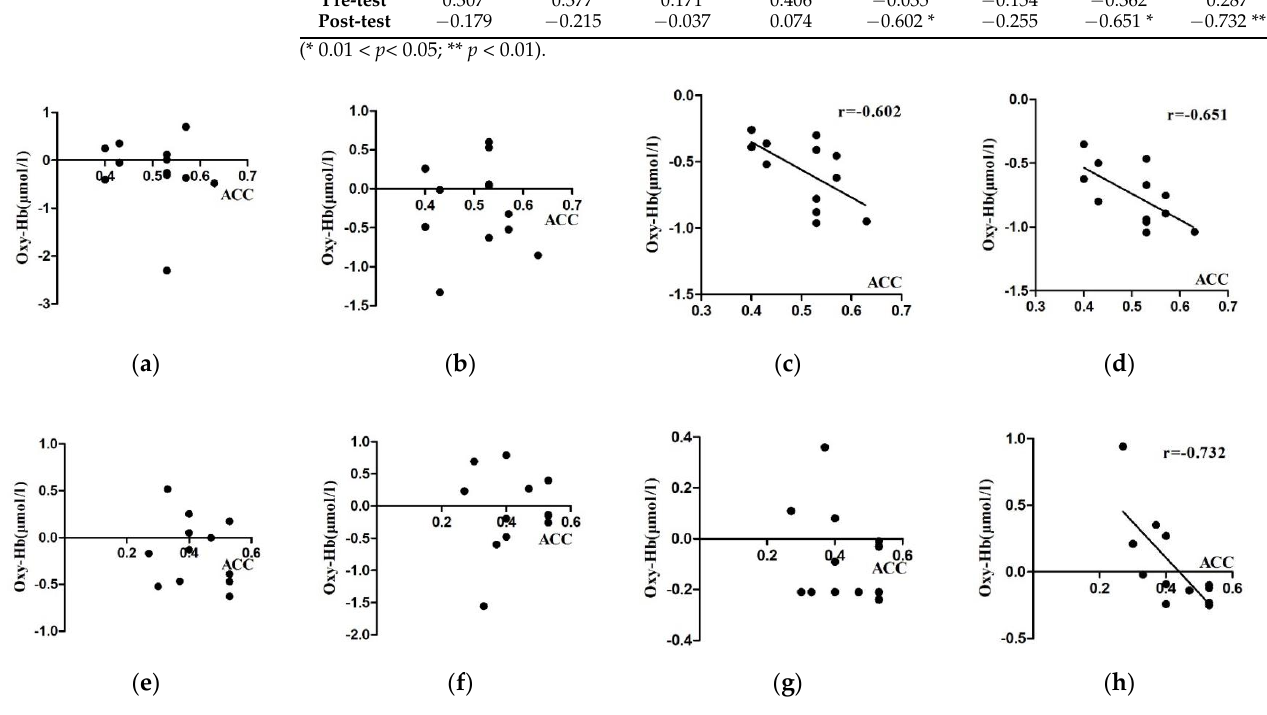
Figure 11. Scatter plot of correlation between fNIRS data and accuracy for the effect of orienteering on gender ‐ specific university students. (Male ( a ): L ‐ VLPFC; ( b ): R ‐ VLPFC; ( c ): L ‐ DLPFC; ( d ): R ‐ DLPFC. Female ( e ): L ‐ VLPFC; ( f ): R ‐ VLPFC; ( g ): L ‐ DLPFC; ( h ): R ‐ DLPFC.)